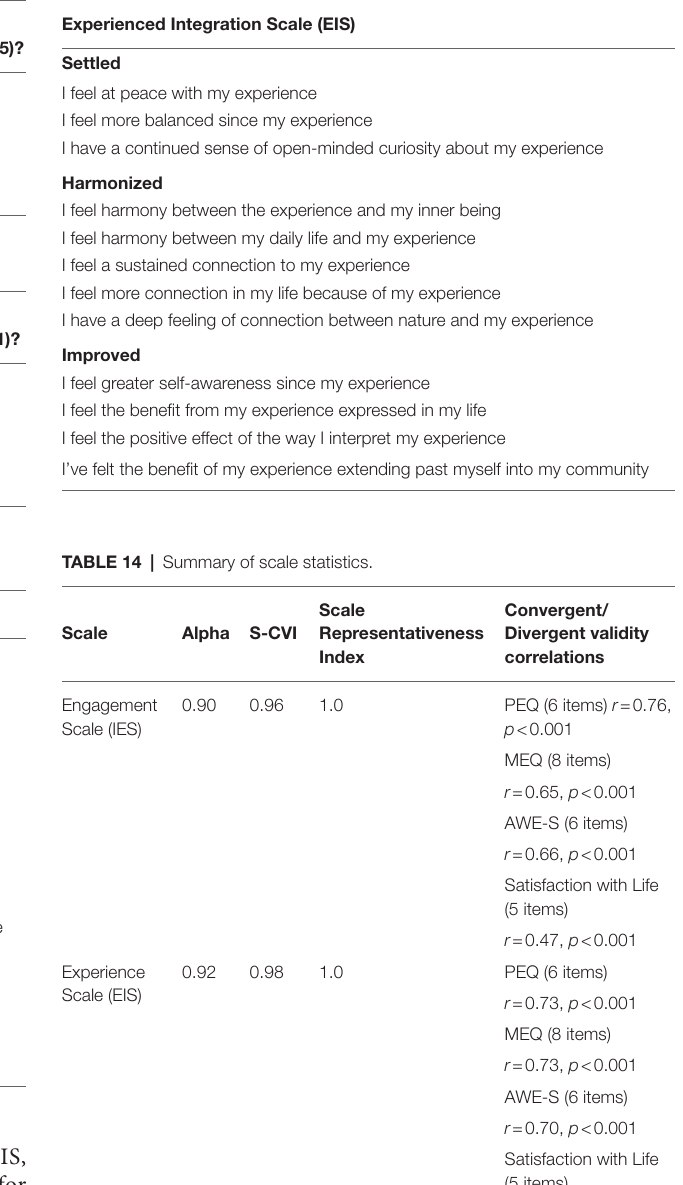
TABLE 10 | Correlation matrix of EIS with related scales.